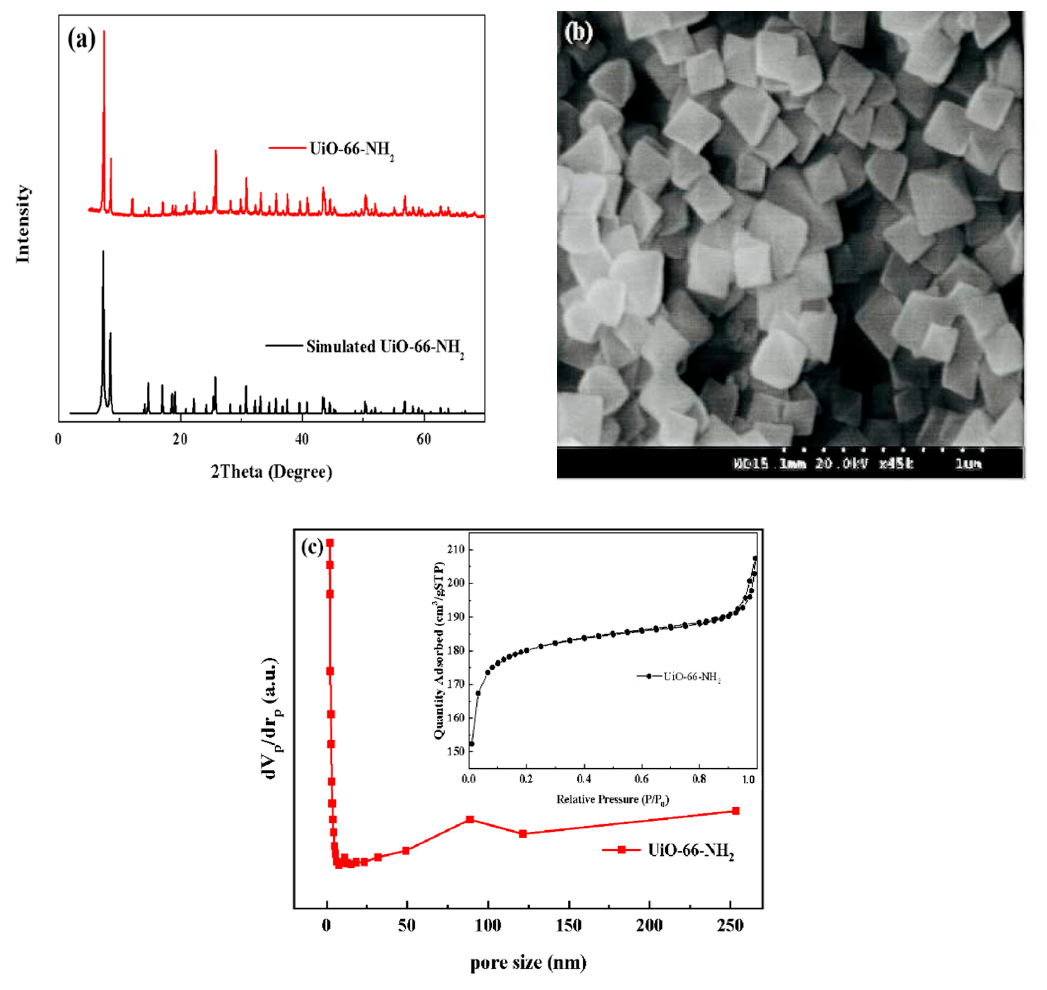
Figure 1. ( a ) XRD patterns of synthesized UiO-66-NH 2 , ( b ) SEM image of synthesized UiO-66-NH 2 , ( c ) nitrogen adsorption isotherm (77 K) and pore size distributions of UiO-66-NH 2 .